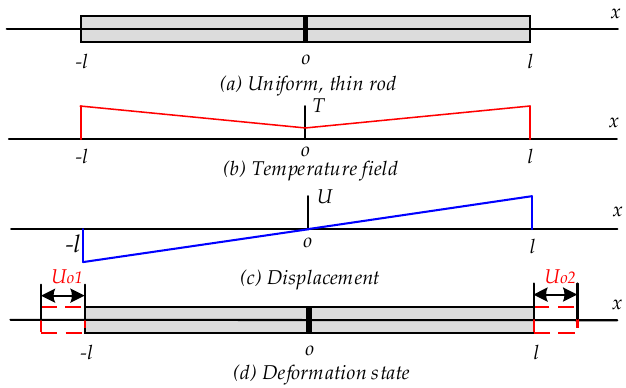
Figure 4. A schematically thermoelastic deformation of the MESG rotor.